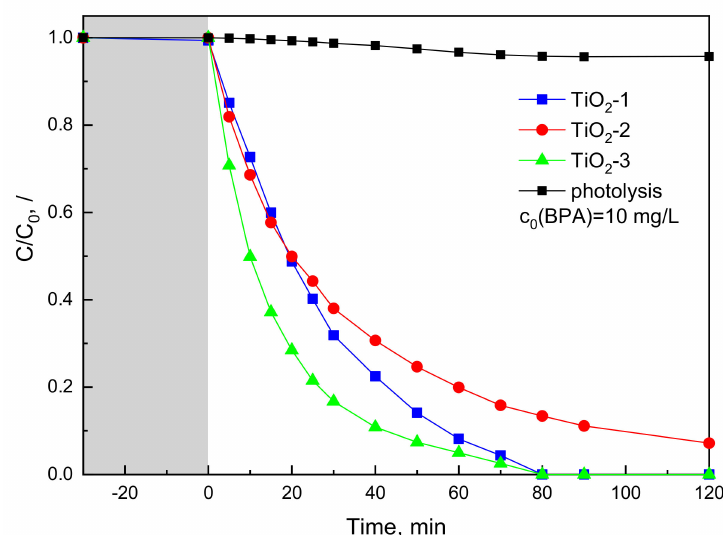
Figure 10. Photocatalytic degradation of aqueous BPA solution in the presence and absence of prepared catalysts irradiated with a UVA Hg lamp (150 W, λ max = 365 nm). The catalyst concentration used